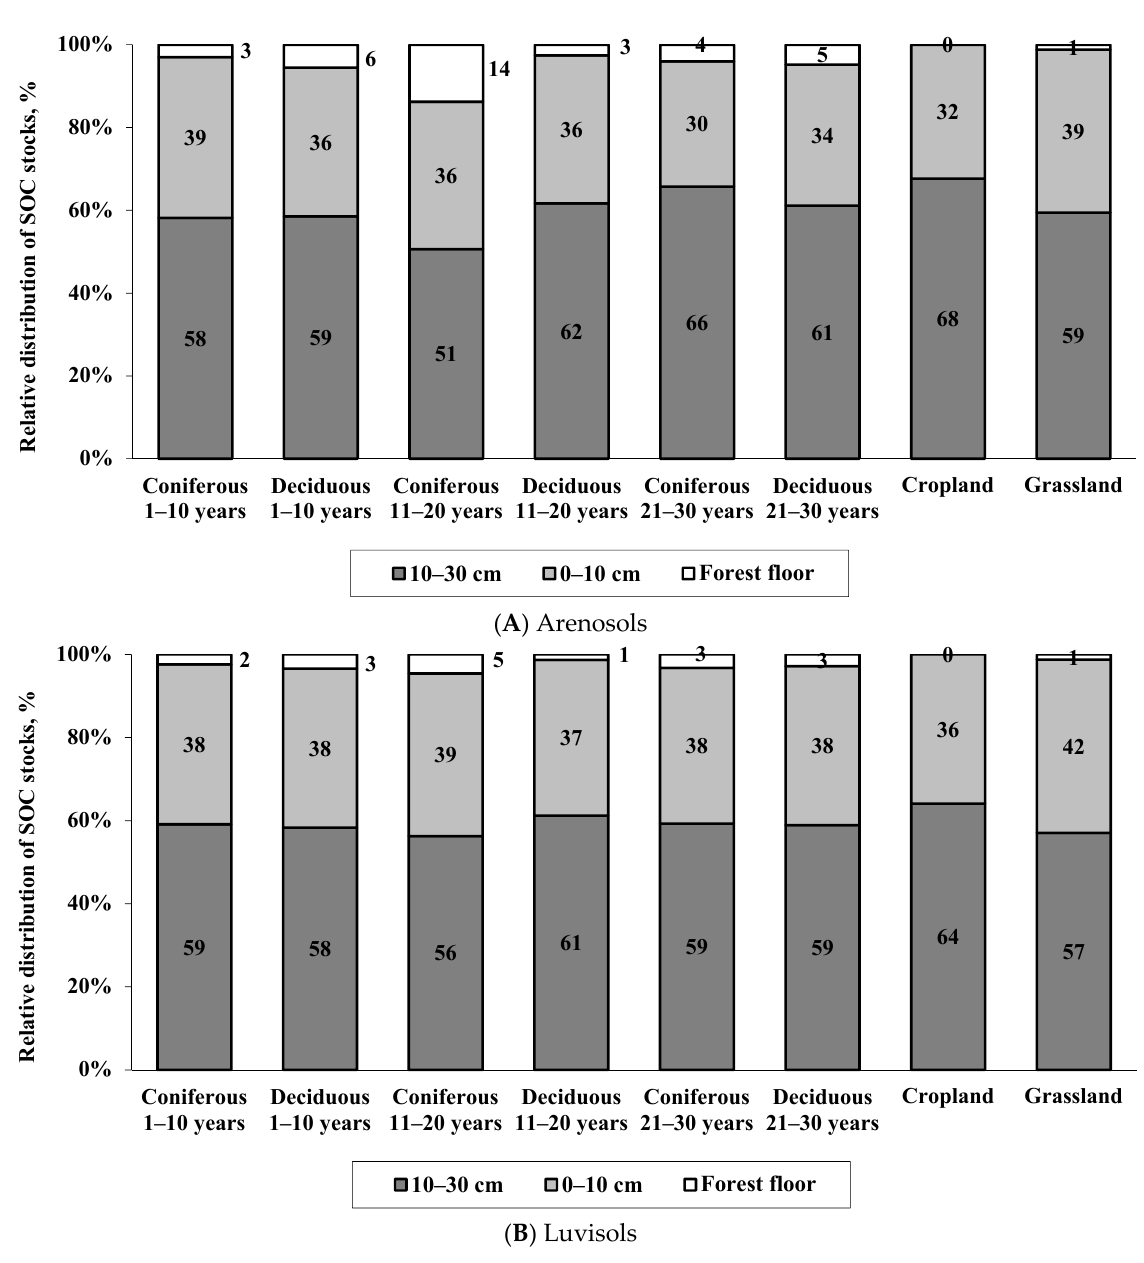
Figure 4. Relative distribution (%) of mean stocks of soil organic carbon (SOC) in forest floor/litter of perennial grassland, 0–10 cm, and 10–30 cm mineral topsoil layers in nutrient ‐ poor Arenosol ( A ) and nutrient ‐ rich Luvisol ( B ) in the 1–10 ‐ year ‐ old, 11–20 ‐ year ‐ old and 21–30 ‐ year ‐ old coniferous and deciduous stands, cropland, and grassland.